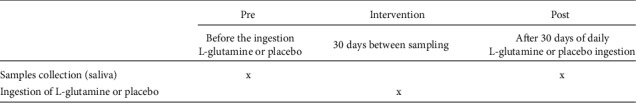
Experimental design.